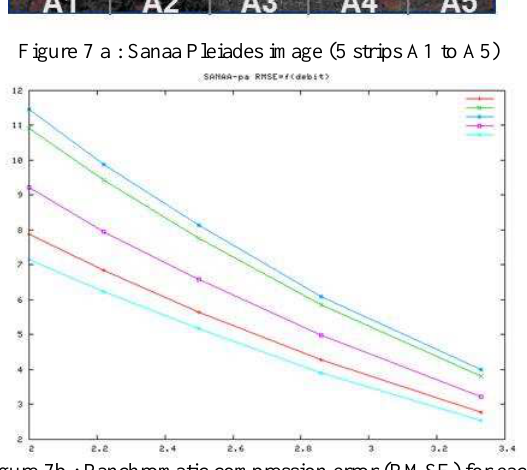
Figure 7b : Panchromatic compression error (RMSE) for